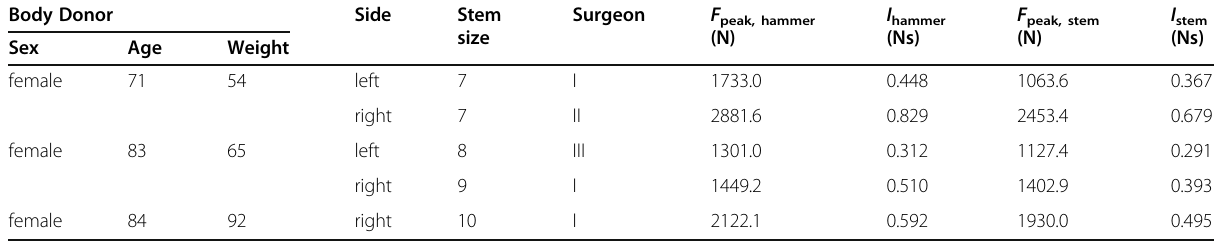
Table 1 Results of impactions on human cadavers Body